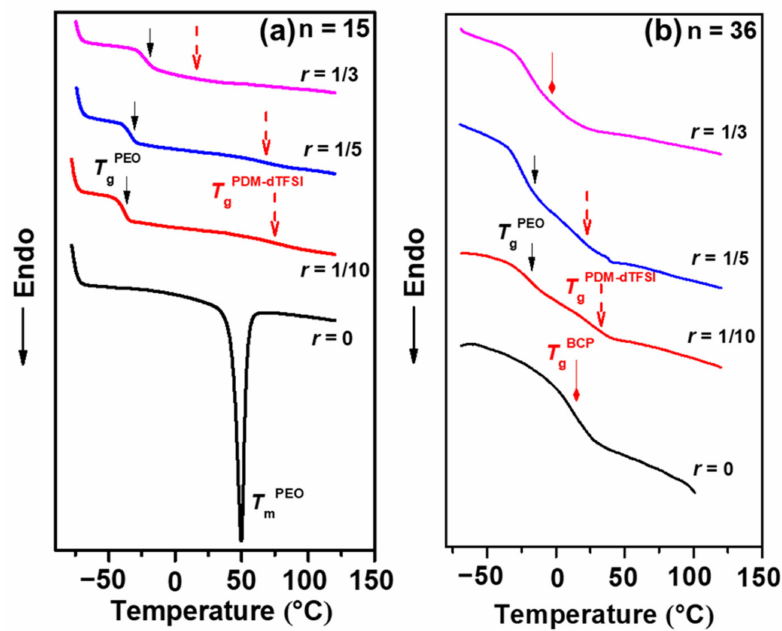
Figure 1. The DSC curves of the PEO 114 - b -PDM n -dTFSI/LiTFSI electrolytes when n is ( a ) 15 and ( b ) 36 in the second heating scans. Table 2. Thermal properties of the PEO 114 - b -PDM n -dTFSI/LiTFSI hybrids.